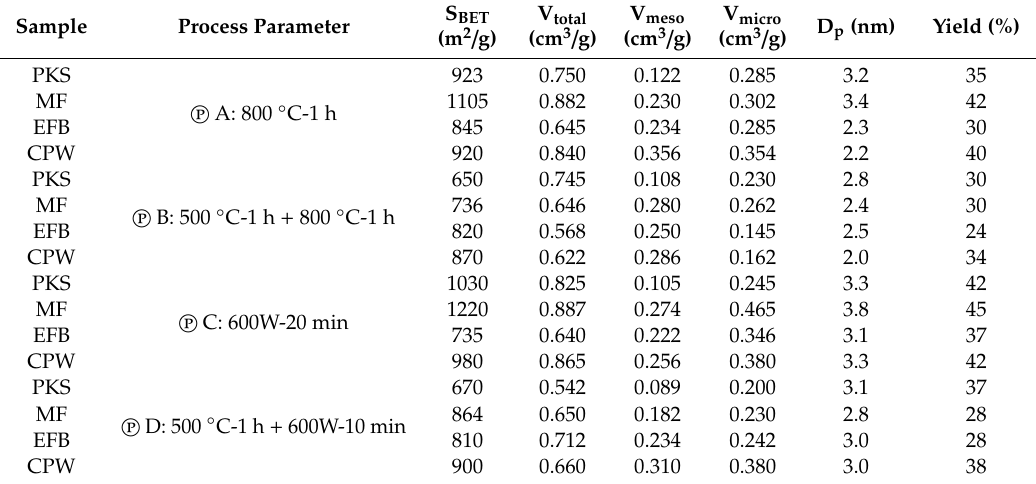
Table 2. Yield and pore structural